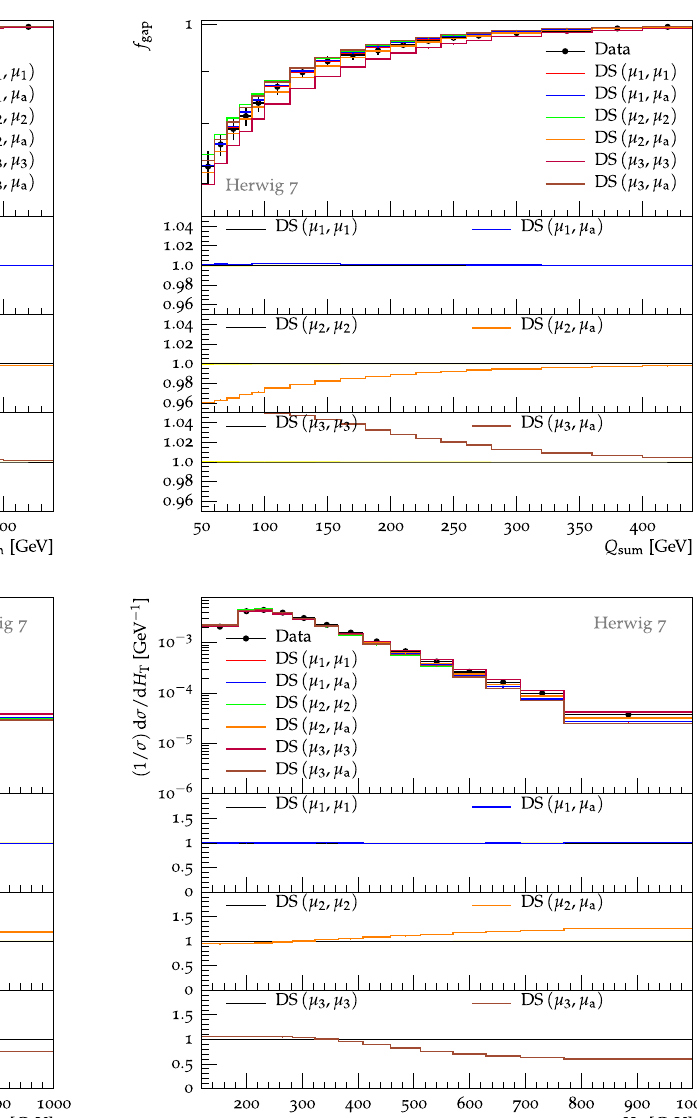
Bottom: combined lepton channel measurement of the H T distribution by CMS in semileptonic 8 TeV pp → t ¯ t events [65] and